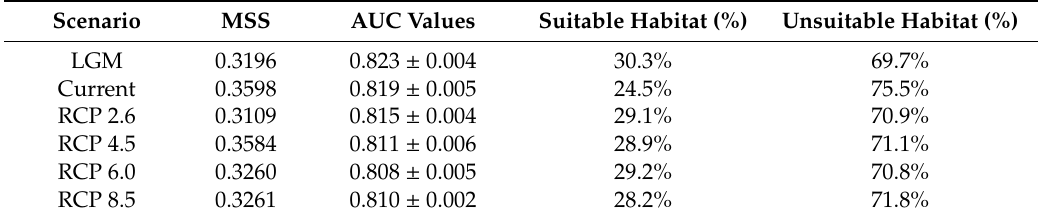
Table 3. The maximum test sensitivity plus specificity threshold (MSS) and model area under the curve (AUC) values with standard deviation for the Last Glacial Maximum (LGM), Current conditions, and four future Representative Concentration Pathway (RCP) scenarios. Including the percentage of suitable and unsuitable habitat based on the MSS threshold.